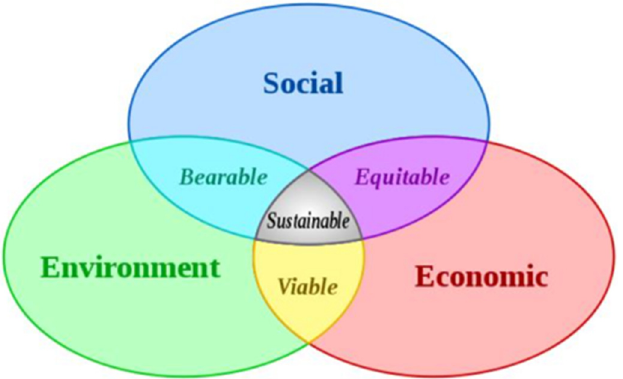
Fig. 1. The triple bottom line (TBL)